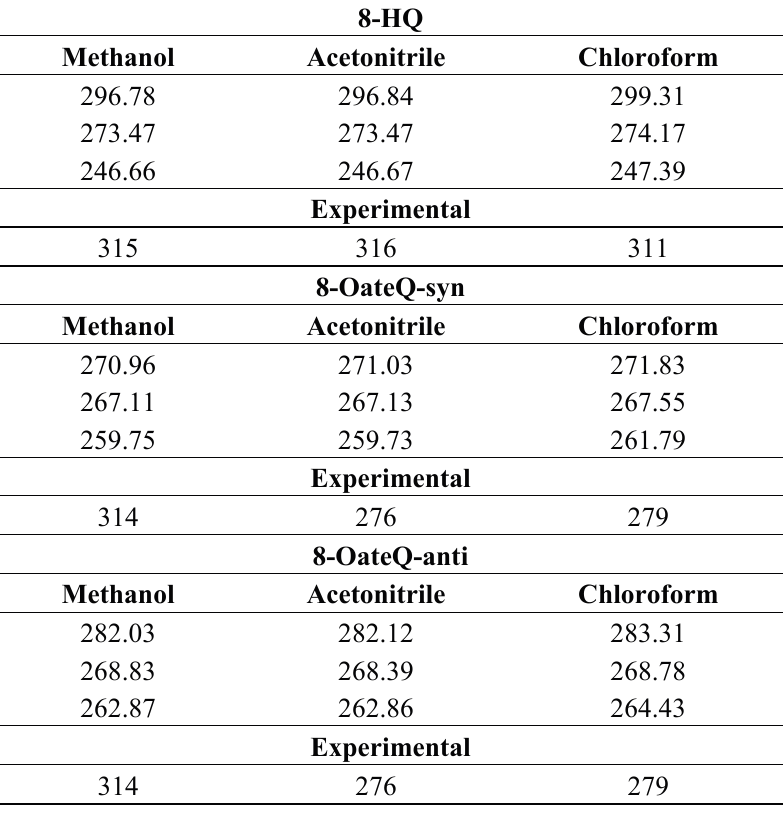
Table 5. Comparison between theoretical CAM-B3LYP/6-311++G** and experimental wavelength for the studied species in different